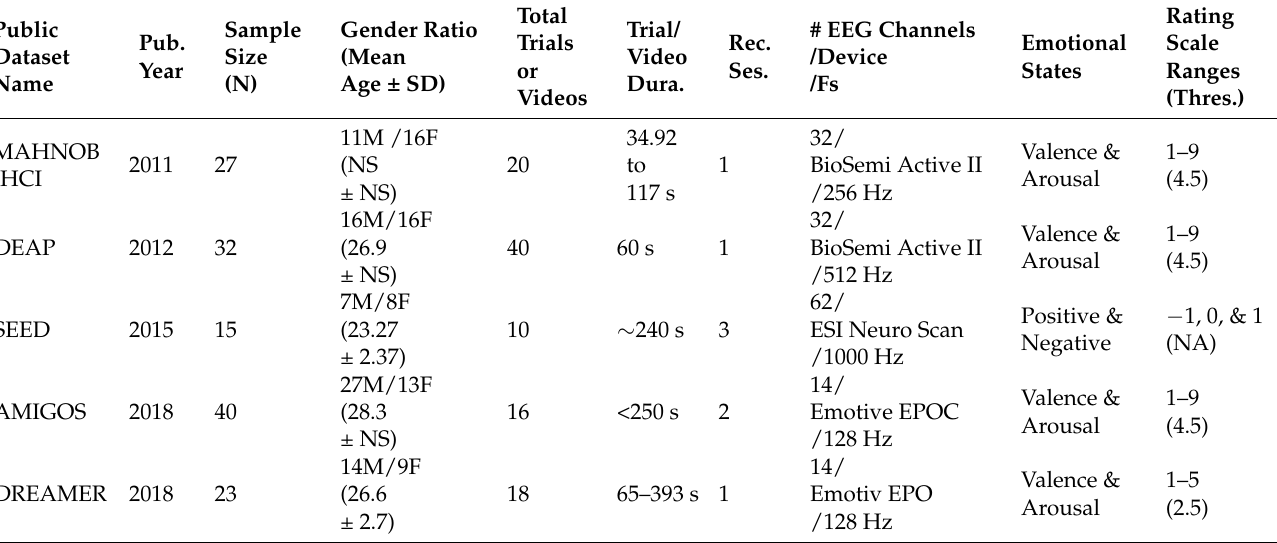
Table 1. Information about the datasets used in this